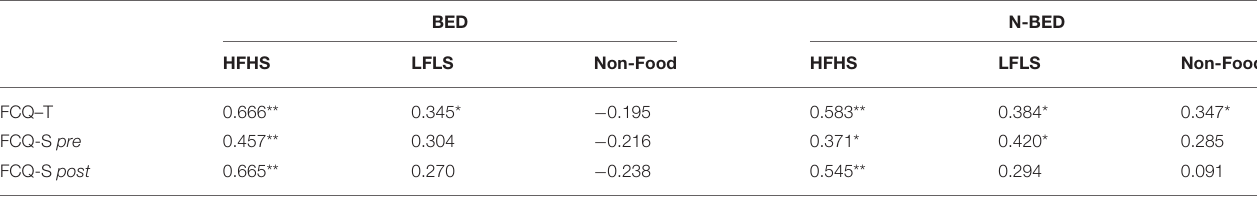
TABLE 2 | Correlations of cue-induced cravings in the BED and N-BED